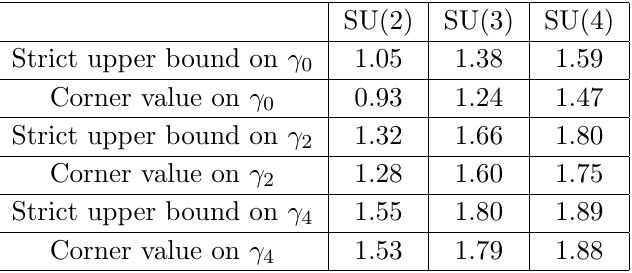
Table 1 . Bounds and corner values from Superconformal bootstrap